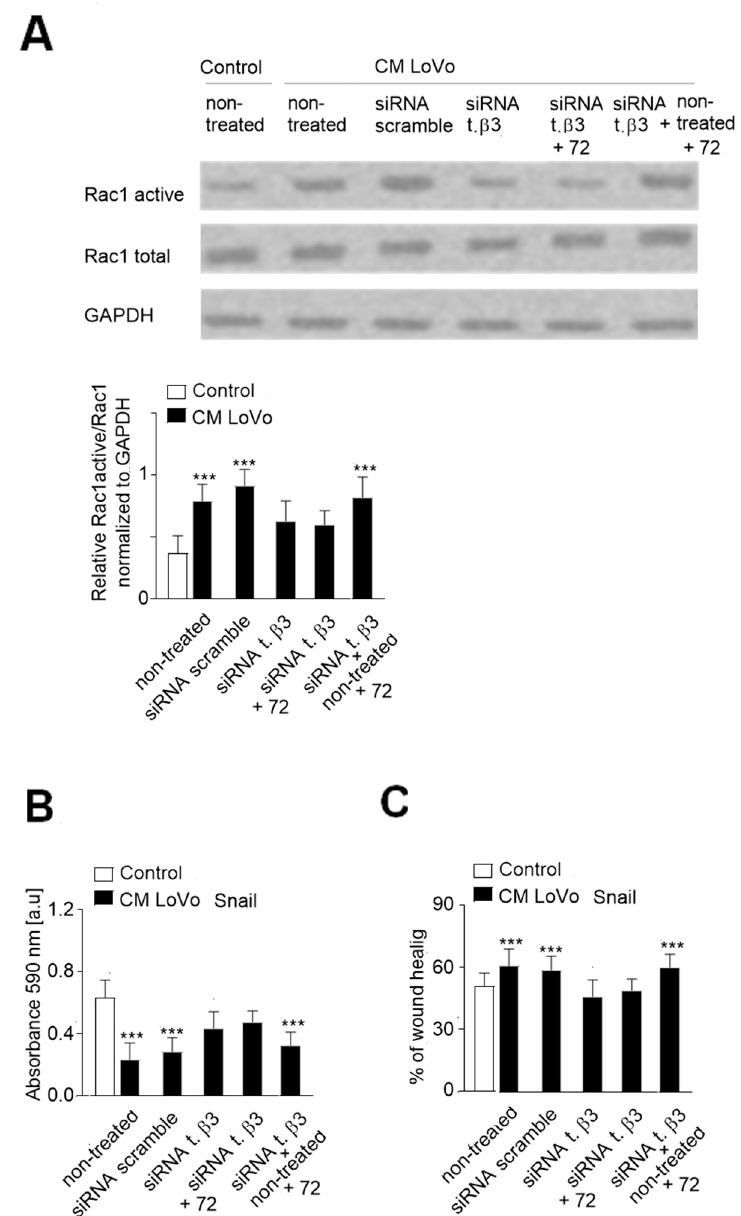
Figure 6. Microtubular tubulin- β 3 regulates CAF behavior via Rac1. HMEC-1 cells were cultured in medium supplemented with conditioned medium (CM) isolated from invasive (LoVo) colon cancer cells where tubulin- β 3 was silenced (siRNA t. β 3). Then, silencing was halted to check the effect of tubulin- β 3 on Rac1 activation and cell behavior. The Rac1 activity was analyzed in control, CM-treated and tubulin- β 3 silenced cells and in the recovery experiments where silencing was halted for 72 h ( A ). GAPDH was used as a loading control. The results are shown as means ± SD ( n = 3); *** p < 0.005. Next, the adhesion to collagen I ( B ) and wound-healing properties ( C ) were analyzed. The results are shown as means ± SD ( n = 3); *** p < 0.005. t. β 3—tubulin- β 3.; +72—the time of the elongated cell treatment.